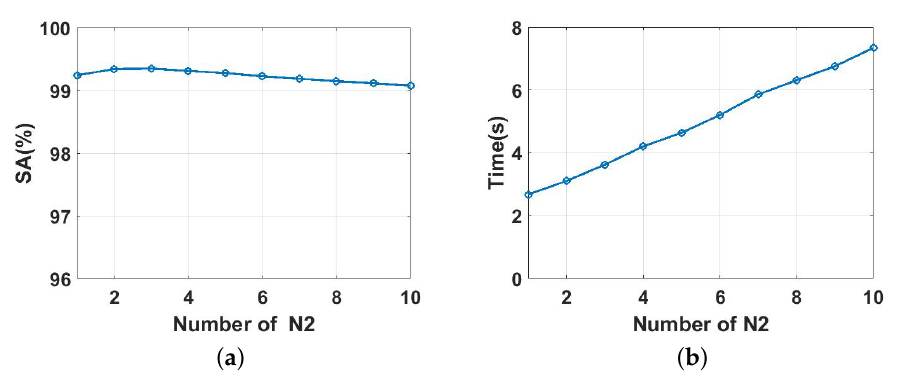
Figure 11. The impact of parameter N 2 on results: (a) the impact on accuracy, (b)the impact on time consumption.